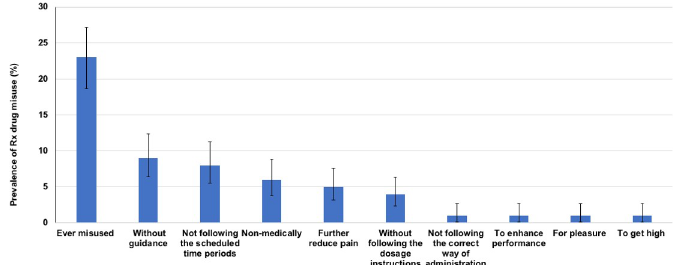
Fig 3. The prevalence of misuse and the types of prescription drug misuse with a 95% confidence interval reported by people living with HIV in the eThekwini district.